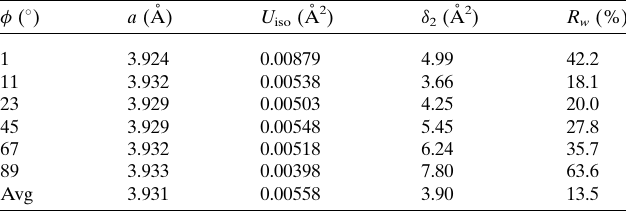
Table 3 1D PDF refinement results for the Pt thin film measured at different incidence angles, (cid:3) , and a fit to an experimental PDF obtained as an average over all tilt angles. Refinement parameters: a is the lattice parameter, U iso is the isotropic atomic displacement parameter, (cid:6) 2 is the coherent thermal-motion parameter and R w is the goodness of the